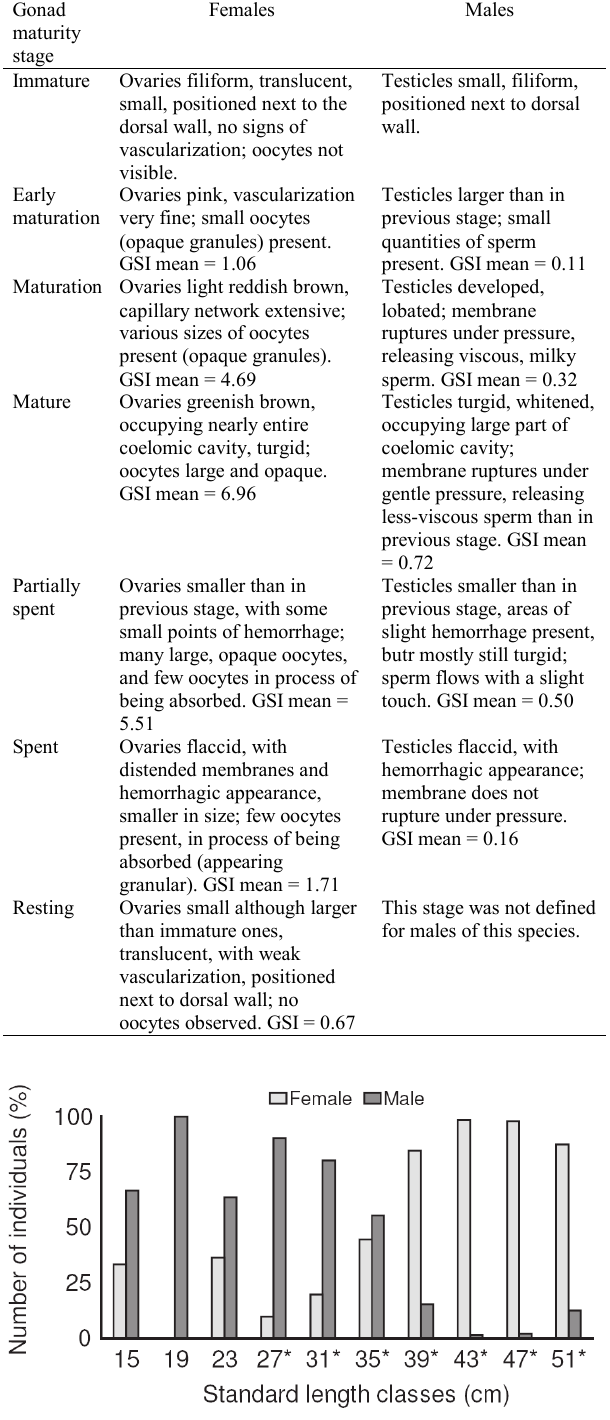
Fig. 3. Sexual maturity curve for females (a) and males (b) of Rhaphiodon vulpinus .